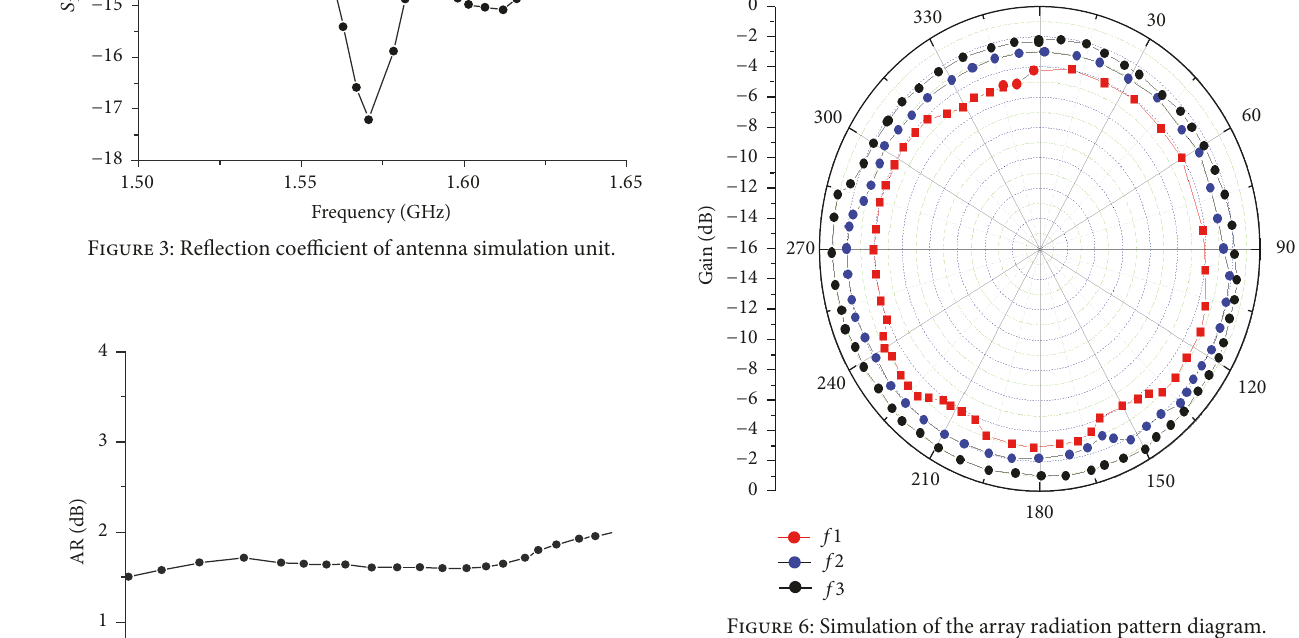
Figure 6: Simulation of the array radiation pattern diagram.